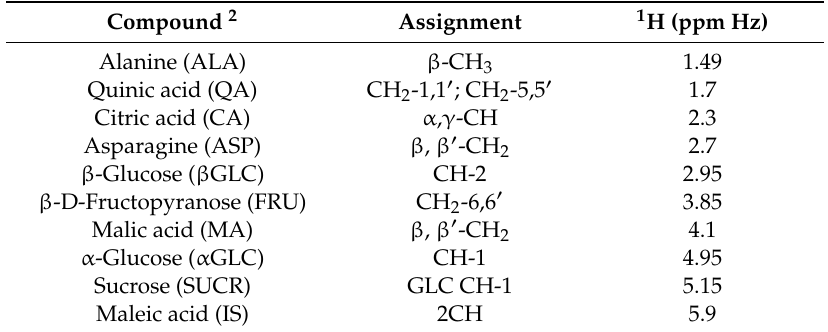
Table 1. Summary of the 1 H NMR signals for the spectra of pear and peach used for the statistical analyses. Compound 2